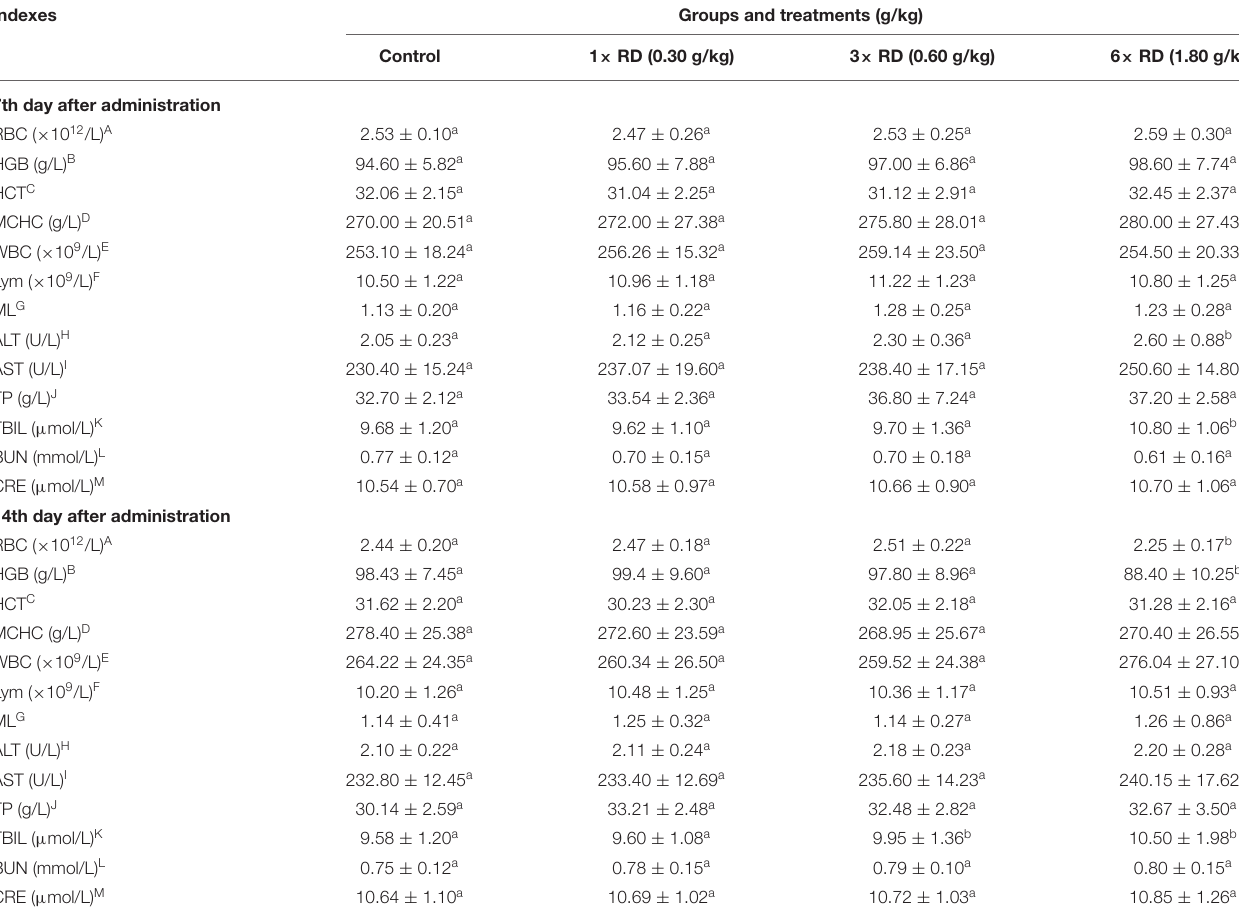
TABLE 5 | Effects of Qinghao Powder on hematological and serum biochemical indexes of chicks in the safety test ( n = 10). Indexes Groups and treatments